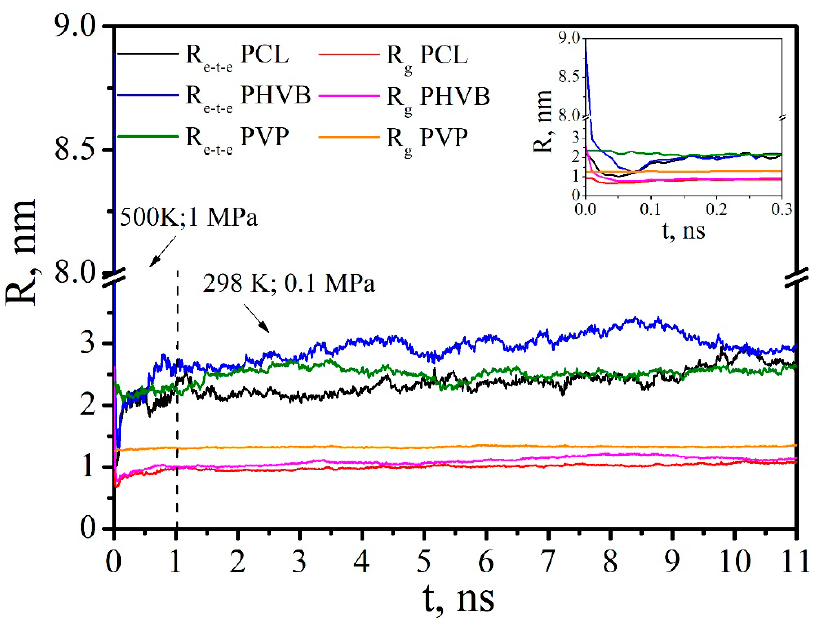
Figure 24. The time dependence of the end-to-end distance and radius of gyration for PCL, PHVB, and PVP.